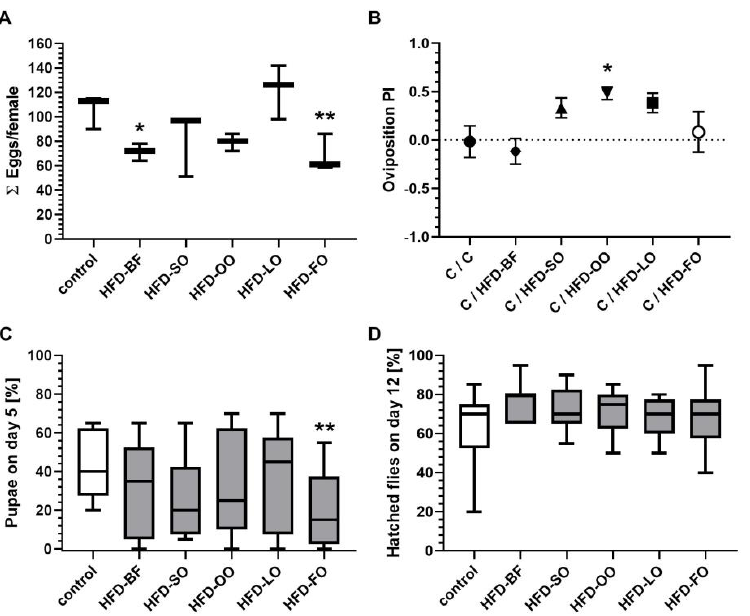
Figure 8. Female fecundity and oviposition as well as egg to adult development were affected by HFD in a fat quality dependent manner. ( A ) To assess female fecundity, two D. melanogaster w 1118 females at a time were maintained in vials containing sugar yeast medium (control) or an HFD and